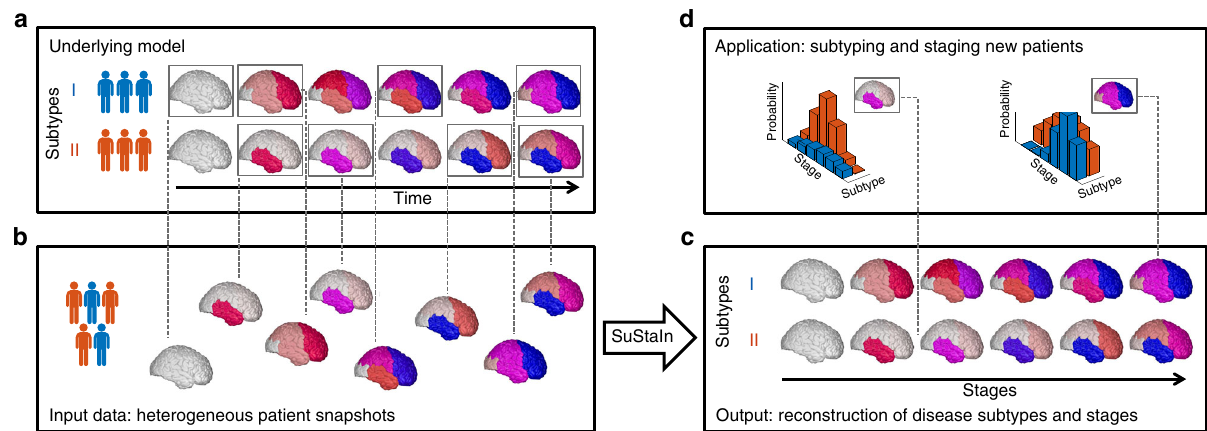
Fig. 1 Conceptual overview of SuStaIn. The Underlying model panel ( a ) considers a patient cohort to consist of an unknown set of disease subtypes. The input data (Input data panel, b ), which can be entirely cross-sectional, contains snapshots of biomarker measurements from each subject with unknown subtype and unknown temporal stage. SuStaIn recovers the set of disease subtypes and their temporal progression (as shown in the Output panel, c ) via simultaneous clustering and disease progression modelling. Given a new snapshot, SuStaIn can estimate the probability the subject belongs to each subtype and stage, by comparing the snapshot with the reconstruction (as shown in the Application panel, d ). This fi gure depicts two hypothetical disease subtypes, labelled I and II, and the biomarkers are regional brain volumes, but SuStaIn is readily applicable to any scalar disease biomarker and any number of subtypes. The colour of each region indicates the amount of pathology in that region, ranging from white (no pathology) to red to magenta to